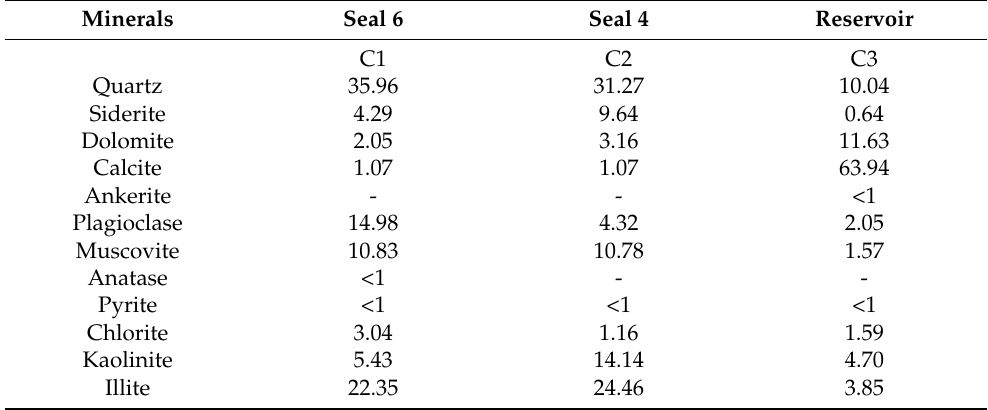
Table 1. Semi-quantitative mineralogical composition of selected cores (weight %) after Rietveld refinement, normalized to